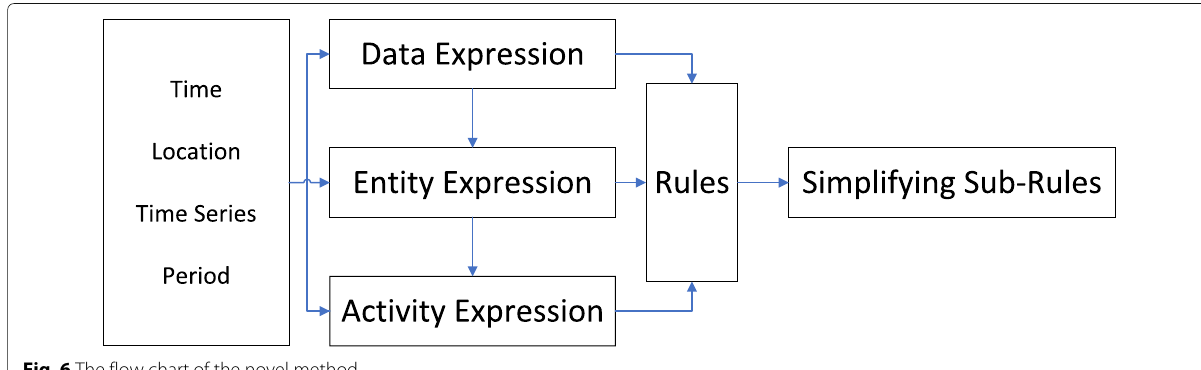
Fig. 6 The flow chart of the novel method